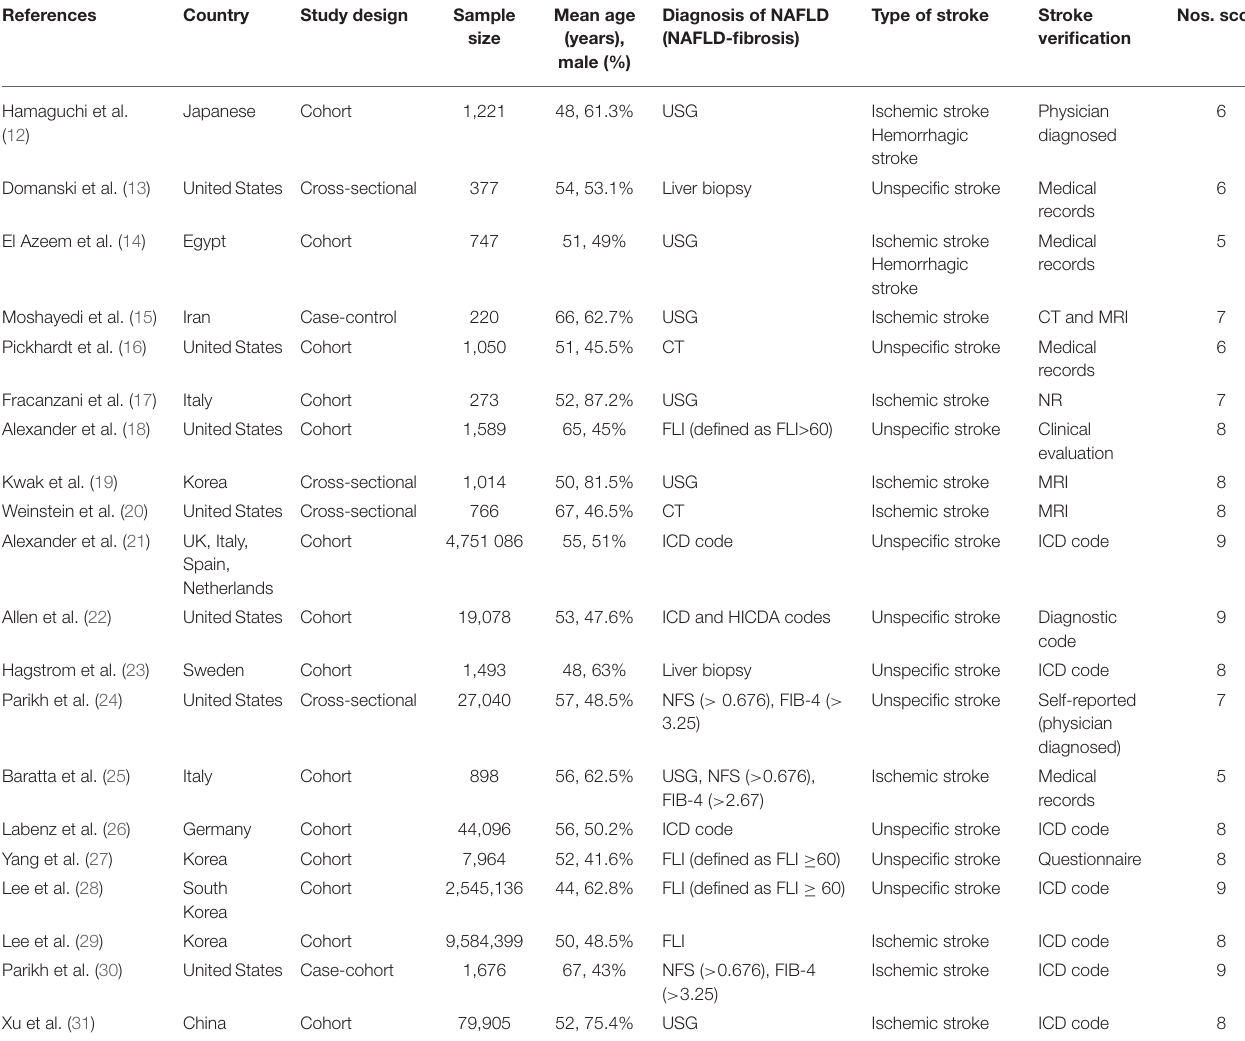
TABLE 1 | Main characteristics of included